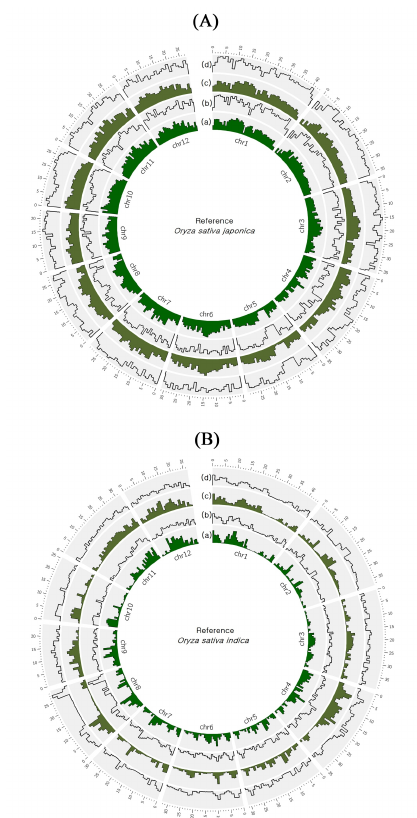
Figure 1. Frequency distribution of single nucleotide polymorphisms (SNPs) and InDels in At 354 and Bg 352. ( A ) with reference to Nipponbare, ( B ) with reference to R498. (a) SNPs–At 354 (b)–InDels At 354 (c) SNPs–Bg 352 (d) InDels–Bg